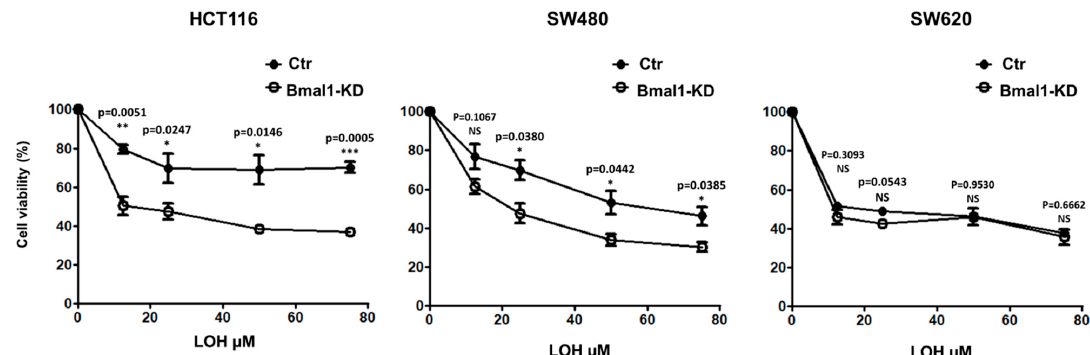
Figure 7. BMAL1-KD sensitizes CRC cell lines to oxaliplatin treatment. The sensitivity of CRC cells to oxaliplatin (LOH) drug was evaluated by the MTT cell viability assay. BMAL1-KD and their control cells were treated for 24 h to 48 h with increasing concentrations of LOH (from 12.5 to 75 μ M). Cell viability after drug treatment is presented as a percentage relative to untreated cells. The mean values for three experiments are shown; error bars correspond to 95% confidence intervals. BMAL1-KD led to a distinct decrease in cell viability of HCT116 and SW480 cell lines under LOH treatment compared to their control cells, whereas no significant differences were observed with the metastasis SW620 cell line ( n = 3, * p < 0.05, ** p < 0.01, *** p < 0.001). Data are shown as means ± SEM.